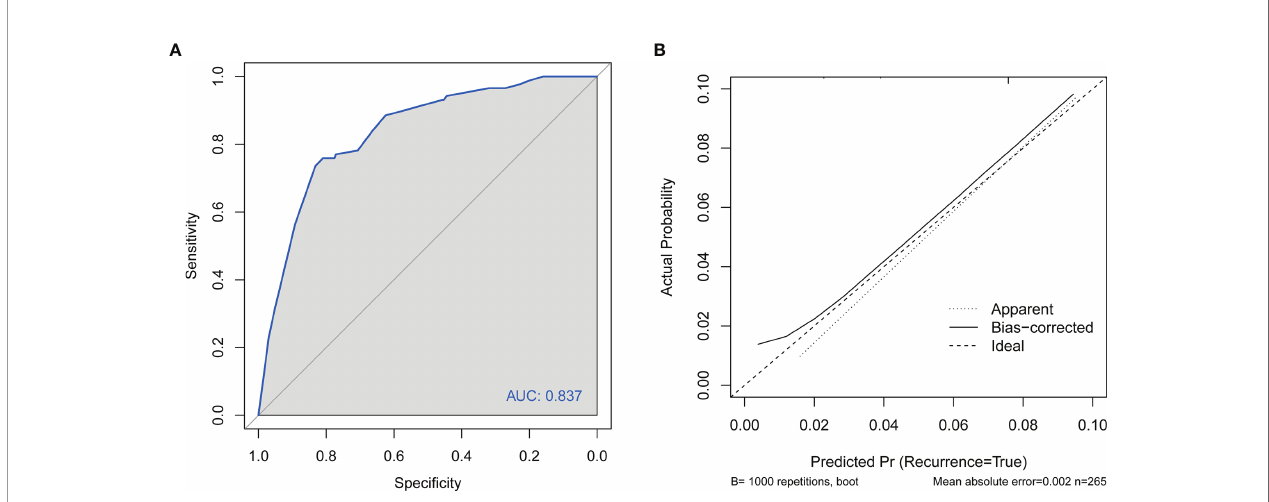
FIGURE 3 | (A) Discrimination for the training cohort. ROC curve of the model with an area under the curve of 0.837 (95% con fi dence interval: 0.741 – 0.910). (B) Calibration of the nomogram to predict live birth in patients with adenomyosis undergoing FET. FET, frozen – thawed embryo transfer; CI, cervical insuf fi ciency; ROC, receiver operating characteristic